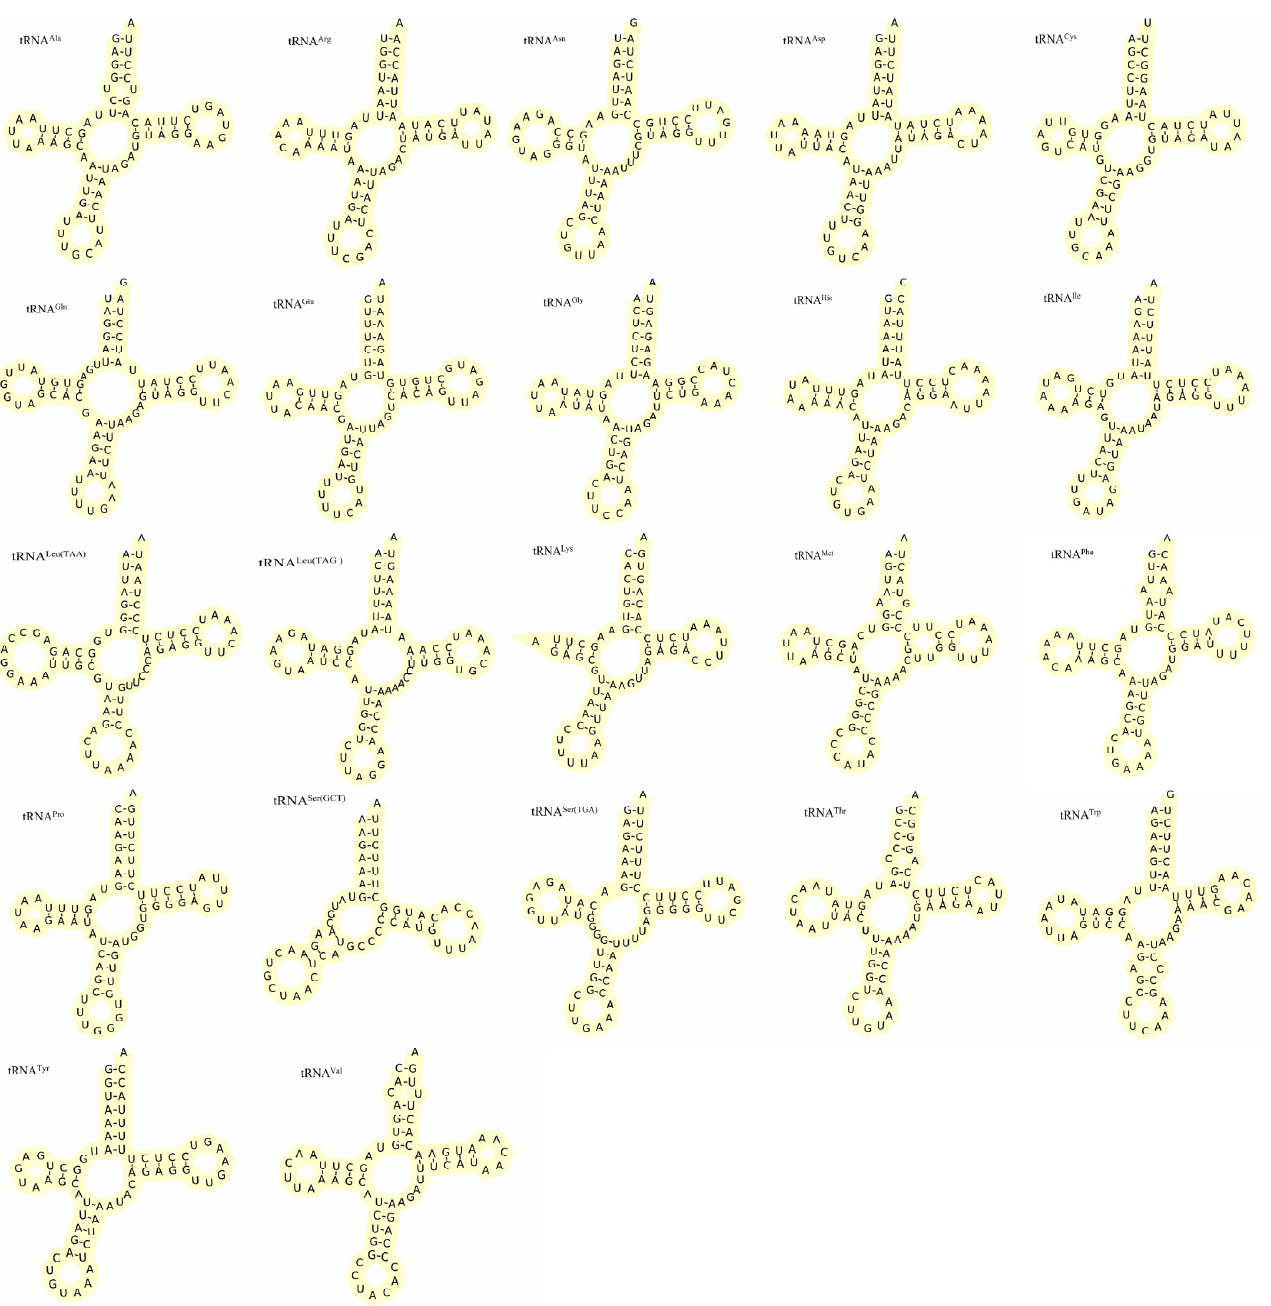
Figure 7. Structures of tRNA of Apodemus draco draco .